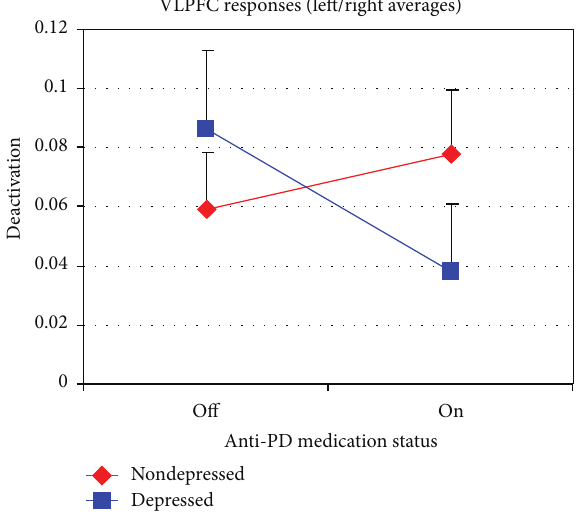
Figure 3: Dopaminergic medication by depression interaction in the ventrolateral prefrontal cortex (VLPFC) in PD patients. Error bars represent the standard error of the